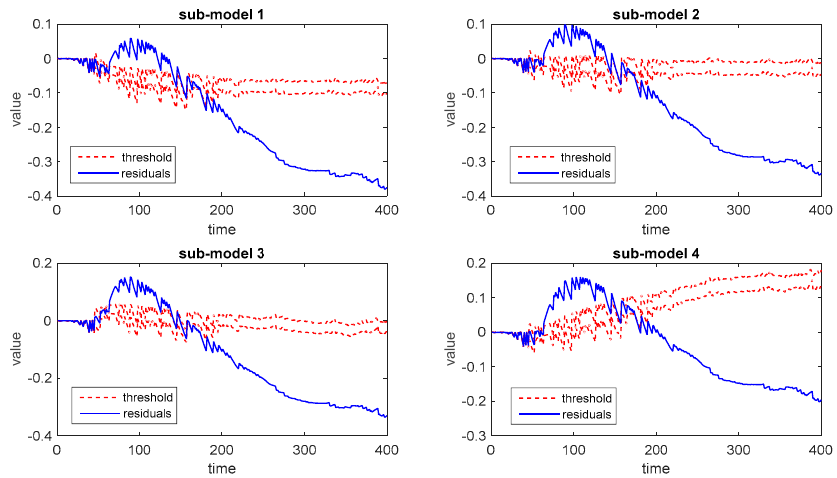
Processes 2020 , 8 , 164 Figure 10. Monitoring results of fault 1 in penicillin fermentation case. Figure 10. Monitoring results of fault 1 in penicillin fermentation case.